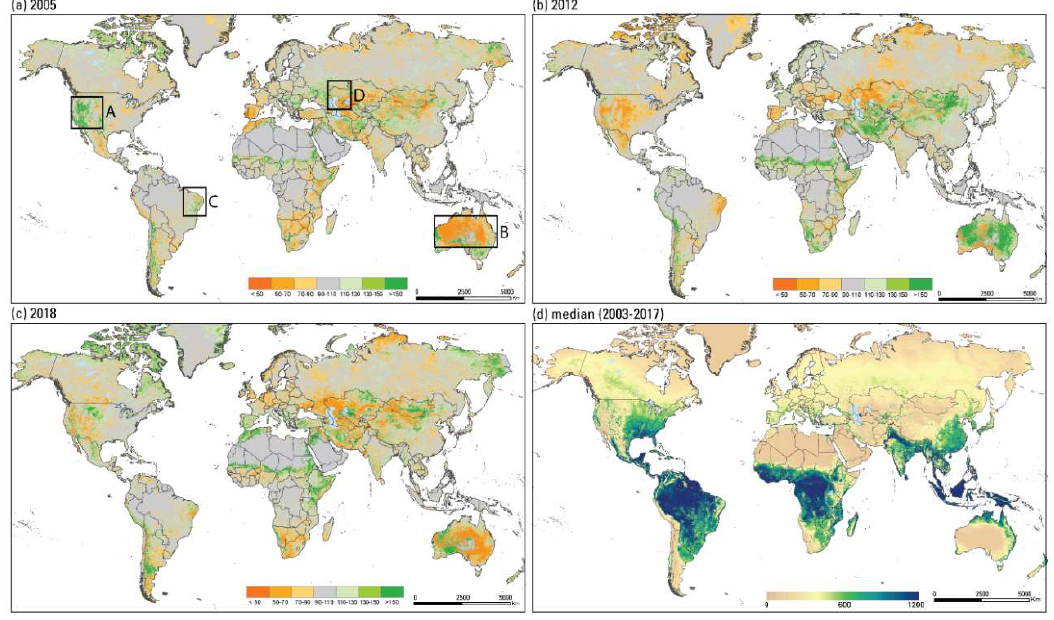
Figure 7. ET anomaly (%) maps for ( a ) 2005, ( b ) 2012, ( c ) 2018, and ( d ) median (2003-2017) actual ET map (mm).